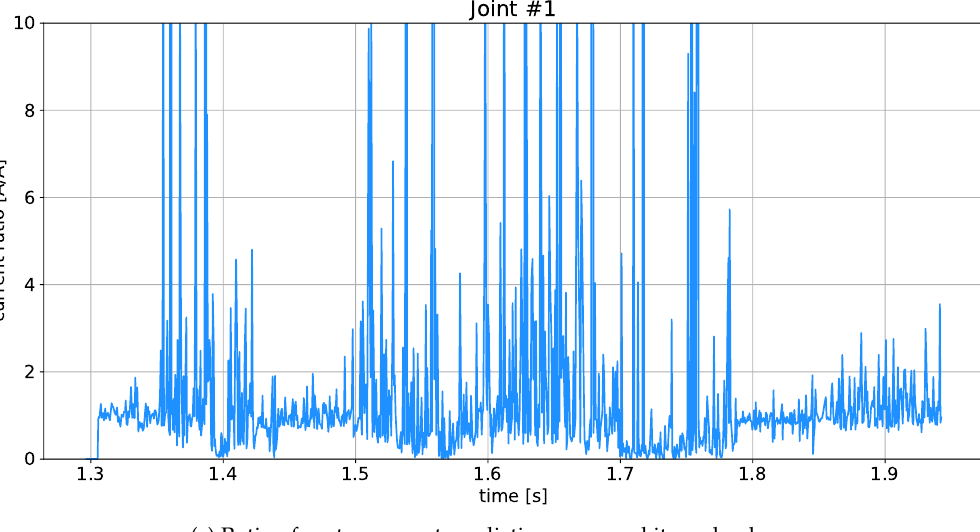
( c ) Ratio of motor current prediction error and its real value. Figure 5. Current trajectories in ampere obtained using the MC-LSTM model for regr ◦ = 12 for example joint